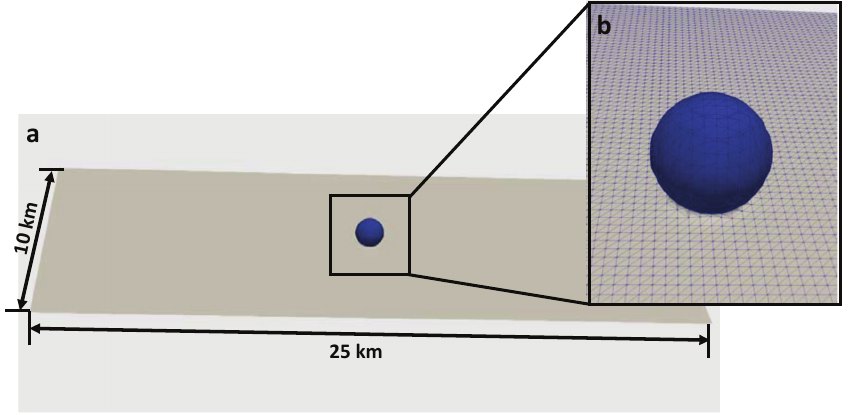
Figure 2. Initialization of 3D FLAG simulations of an aluminum impactor (blue) striking an aluminum target (grey). ( a ) shows the impactor and surface of the 3D target, and ( b ) presents a close-up of the impactor and